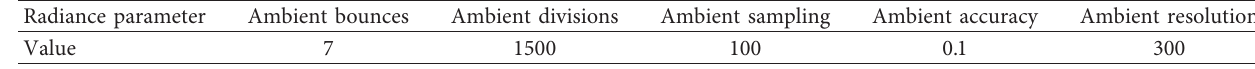
Table 5: Radiance parameters used in daylighting simulation.